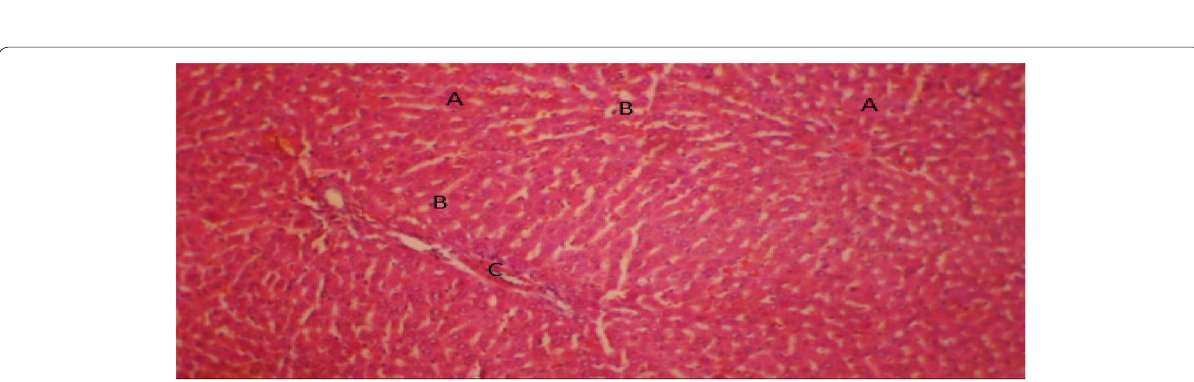
Fig. 8 Liver section of rat co-administered SA and 100mg/kg leaf extract for 14 days (Group 6) showing: A , normal hepatocytes, B , mild Kupffer cell activation and C , normal vascular architecture (H&E x100)